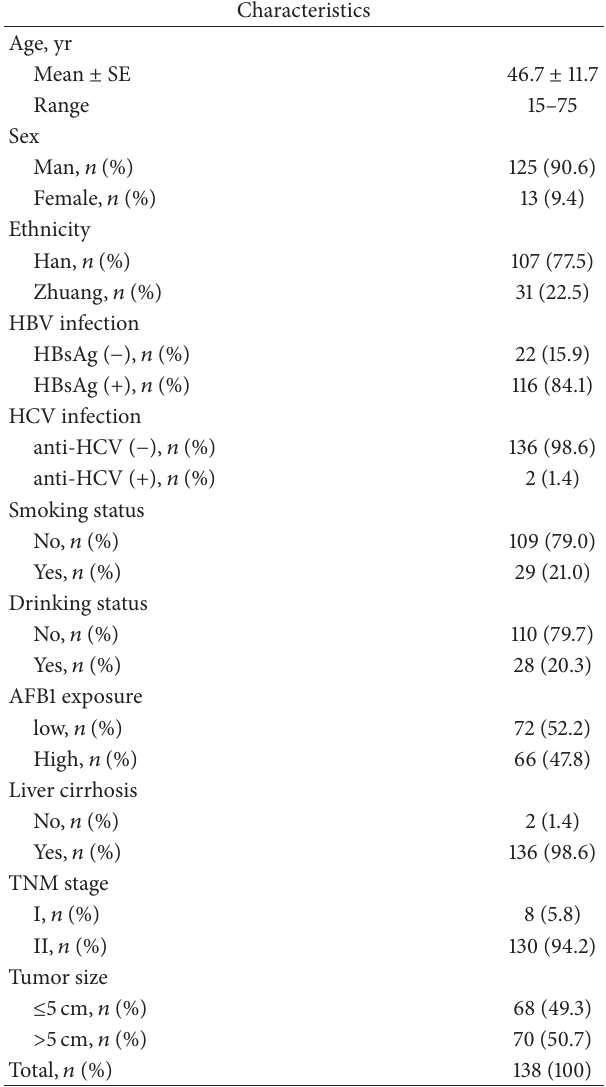
Table 1: Characteristics of the patients with